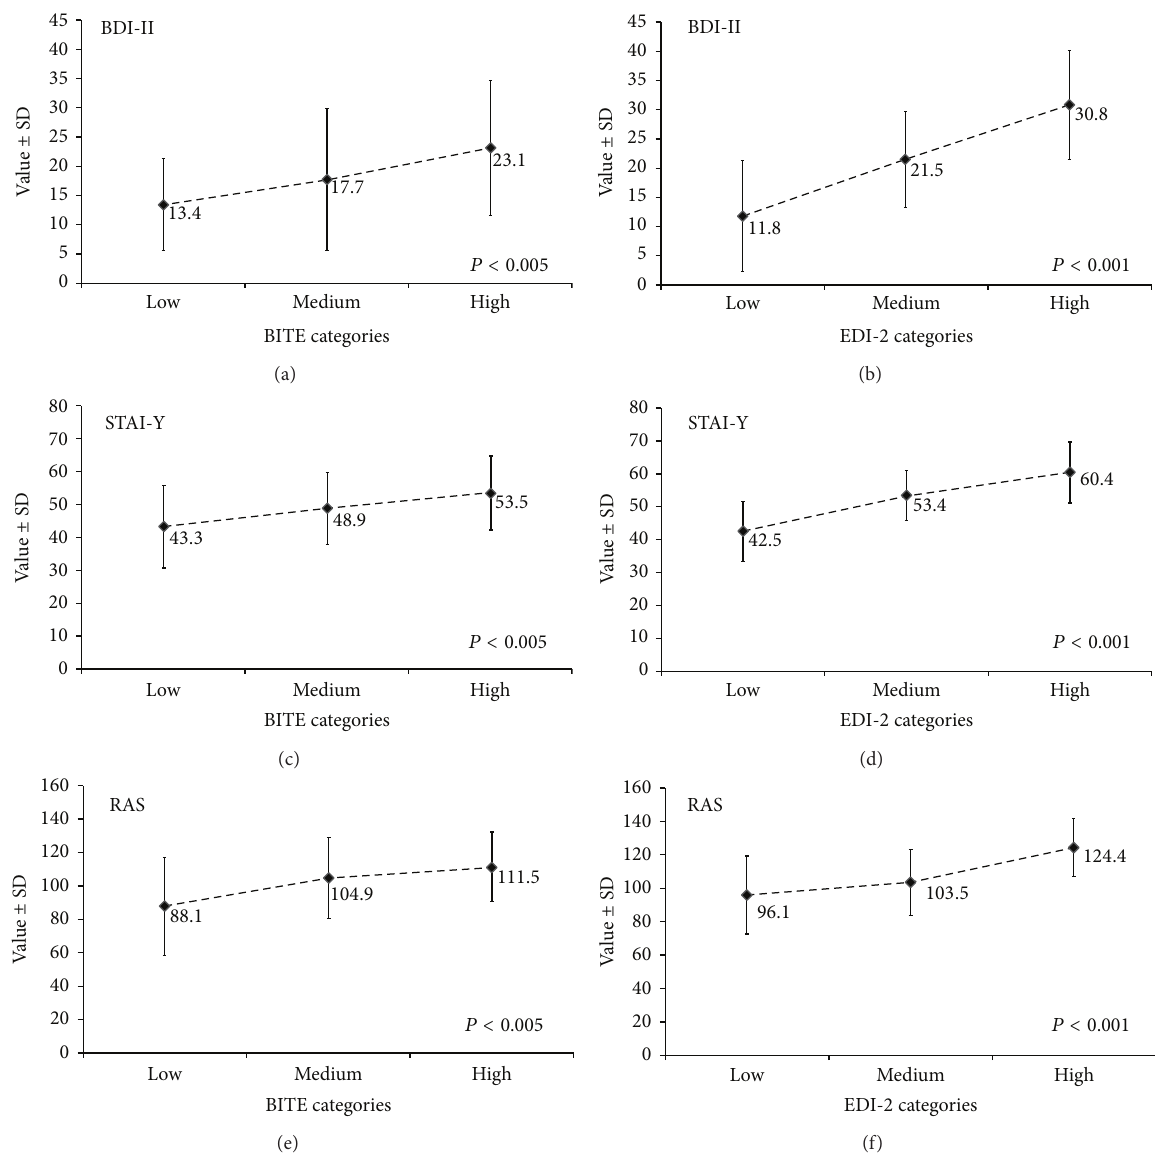
Figure 2: Psychological profile according to eating behaviour categories, as assessed by the Bulimic Investigatory Test of Edinburgh (BITE) symptoms score, and to ineffectiveness groups, as assessed by the Eating Disorder Inventory-2 (EDI-2). Results are expressed as mean ± standard deviation. BDI-II: Beck Depression Inventory II; STAI-Y, Spielberger State-Trait Anxiety Inventory, form Y; RAS: Rathus Assertiveness Schedule. Statistical analyses were performed using Cochran-Armitage trend test for qualitative variables and analysis of variance for quantitative